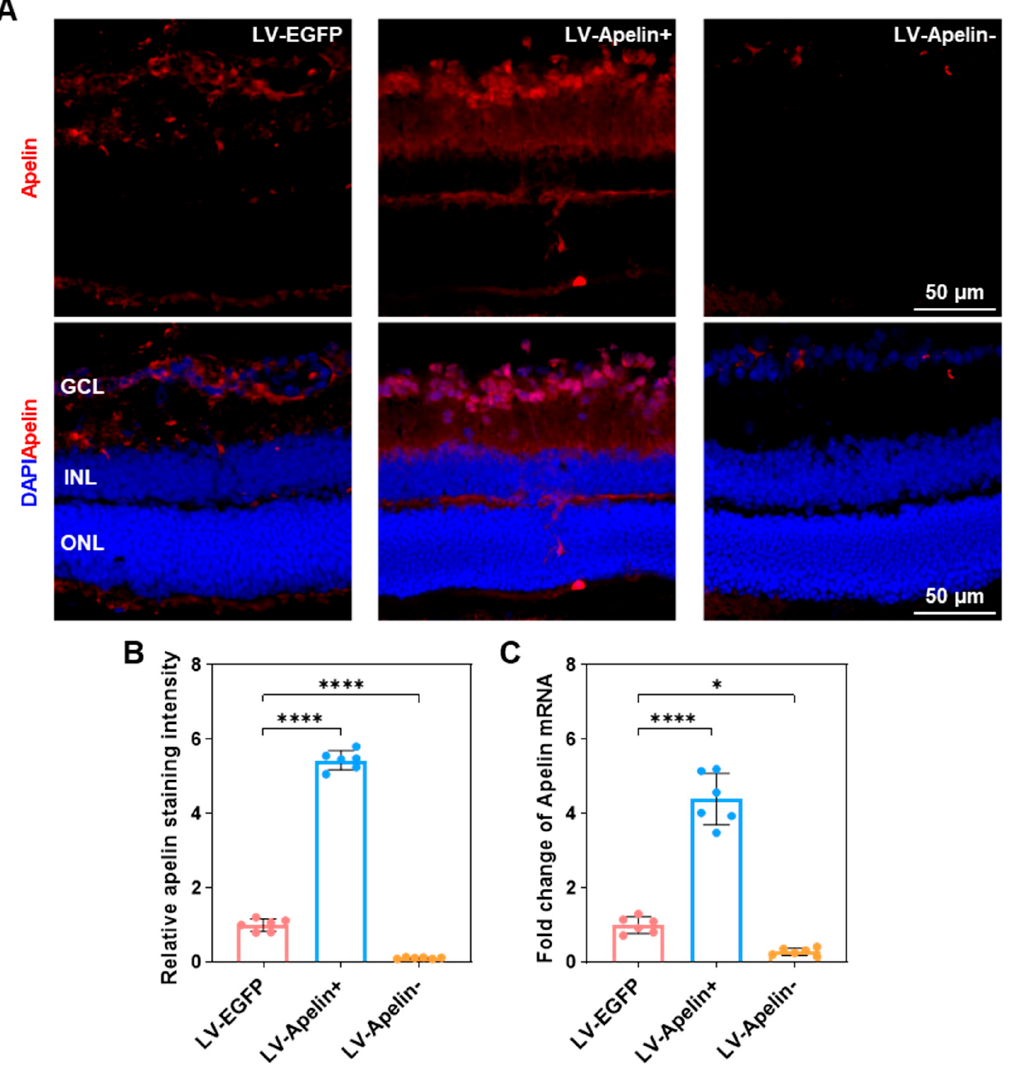
Figure 2. The expression of apelin in DR mice treated with LV-EGFP, LV-Apelin+, or LV-Apelin − . ( A ) Representative apelin staining images by CLSM and ( B ) the quantification of the staining intensity indicated that apelin was moderately expressed in the LV-EGFP group and was primarily distributed in the GCL, while it was widely expressed in the LV-Apelin+ group and distributed in the GCL and INL. In the LV-Apelin − group, there was almost no expression of apelin. ( C ) The qRT-PCR results revealed that the mRNA expression of apelin was upregulated in the LV-Apelin+ group, but downregulated in the LV-Apelin − group. Blue: DAPI, red: apelin. GCL: ganglion cell layer; INL: inner nuclear layer; ONL: outer nuclear layer. Data were expressed as mean ± SD. LV-Apelin+ versus LV-EGFP; LV-Apelin − versus LV-EGFP; * p < 0.05, **** p < 0.0001 (n =